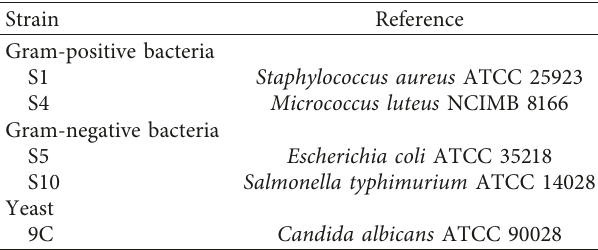
Table 1: The used microbial strains. Strain